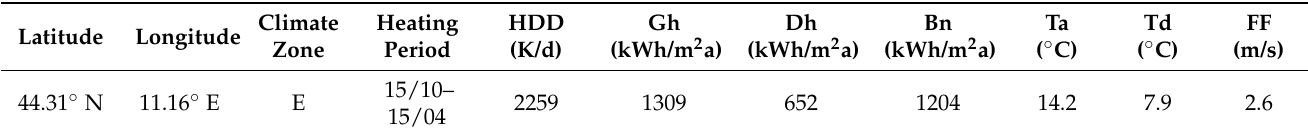
Table 10. Climate data for Borgo Panigale. In the table: HDD means heating degree day, GH stands for global horizontal radiation, Dh means diffuse radiation, Bn means direct normal radiation, Ta stands for air temperature, Td stands for dewpoint temperature and FF means wind speed. The climate data are the annual